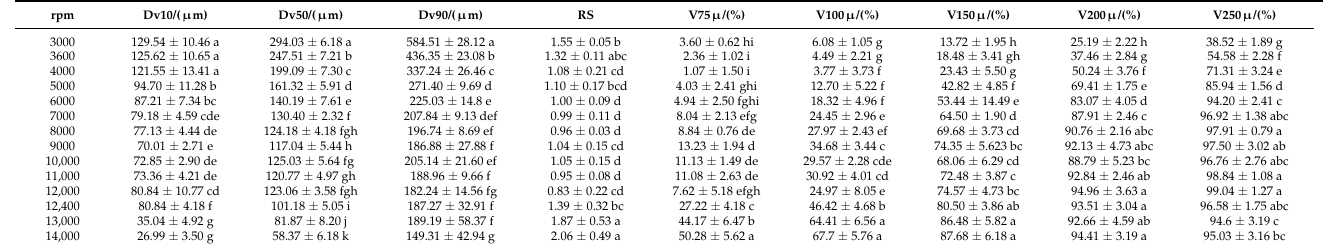
Table 3. Results of the influence of RA revolution speed on droplet parameters. The parameters of the pollen suspension droplets are listed in the table. The mean ± SE is used to tabulate the results.